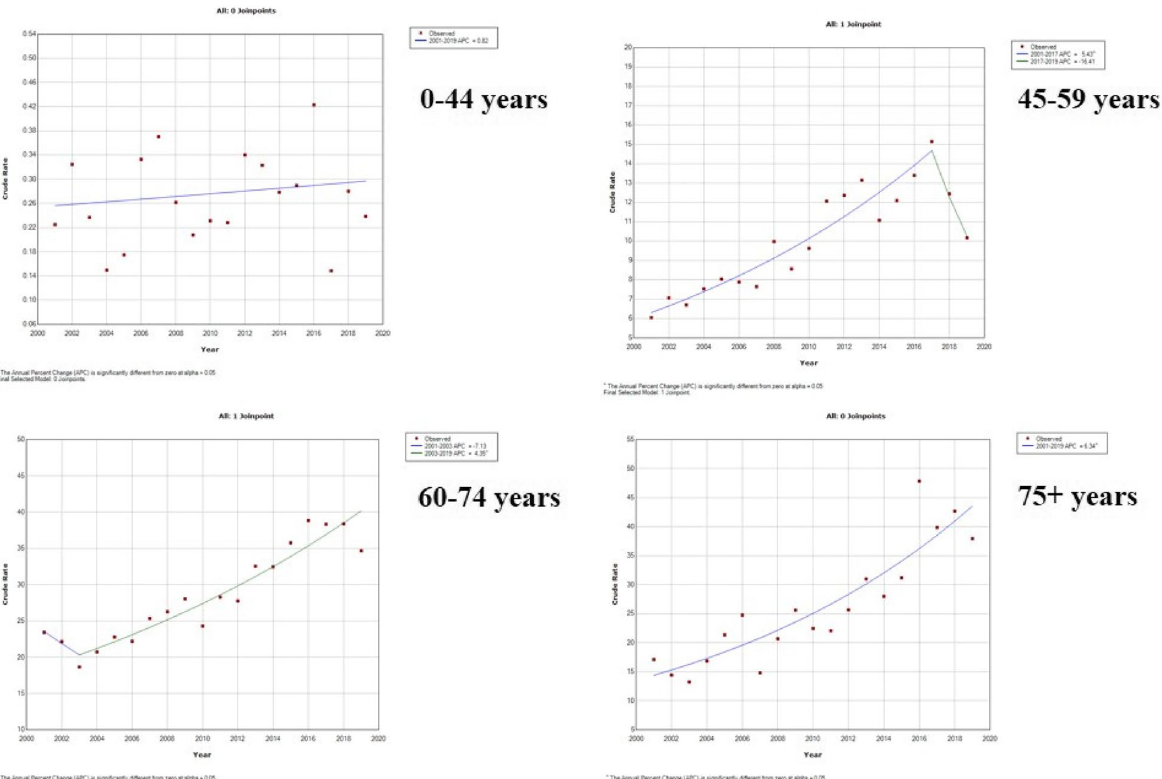
Fig. 4 Joinpoint regression analysis of age-categorised trends in the incidence of laryngeal cancer among males from 2001 to 2019 in Sri